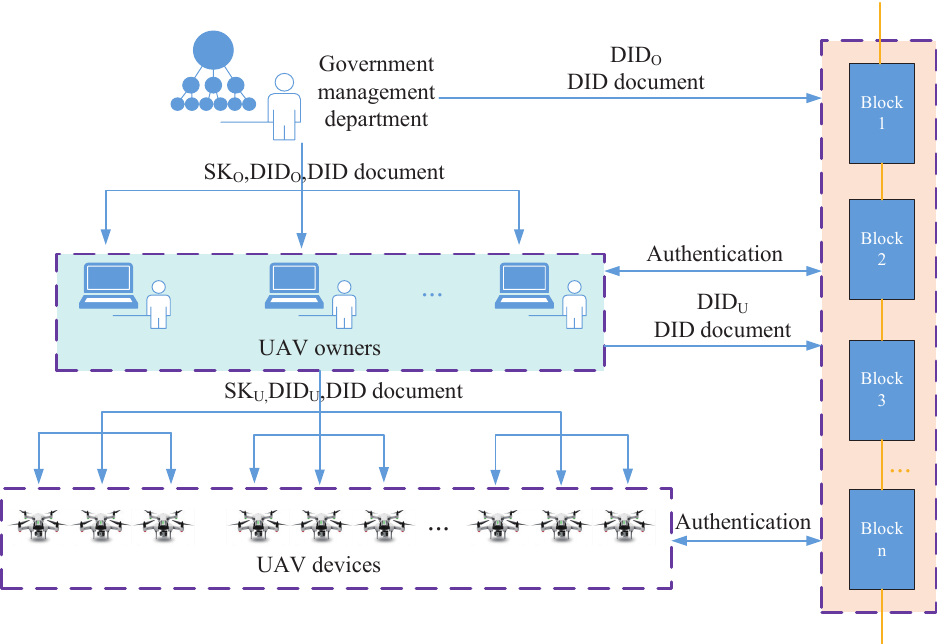
Figure 1. Blockchain-based UAV identity management model.